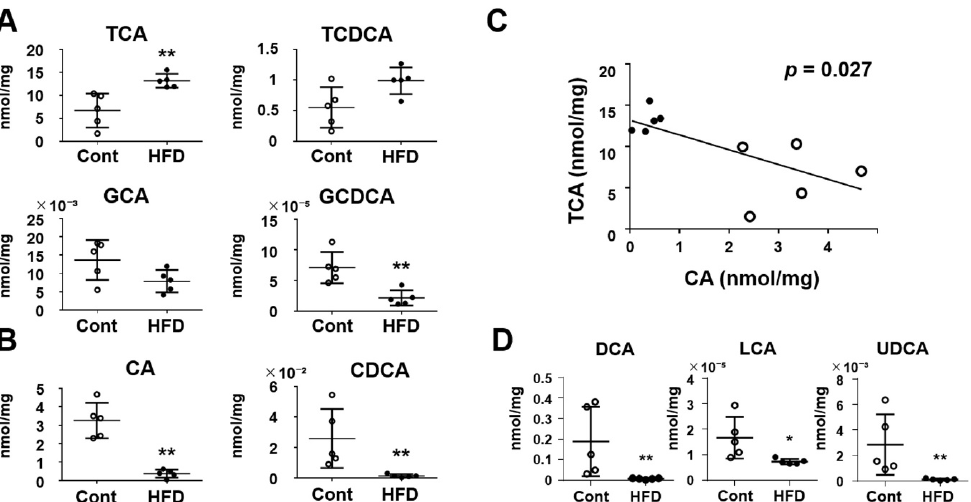
Figure 4. Effect of a HFD on concentrations of bile acids in the small-intestinal contents. ( A ) Conjugated primary bile acids. ( B ) Deconjugated primary bile acids. ( C ) Correlation between TCA and CA. p < 0.05 by linear regression analysis. ( D ) Secondary bile acids. Results are expressed as the mean ± SD. * p < 0.05; ** p < 0.01 vs. control group. Cont, control ( n = 5); HFD, high-fat diet ( n = 5).